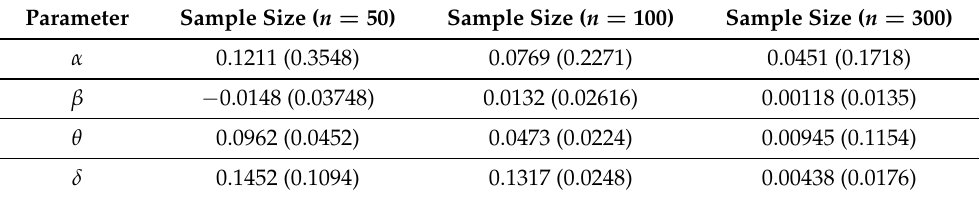
Table 1. Bias and standard deviation for the parameters for bivariate probability model 1.